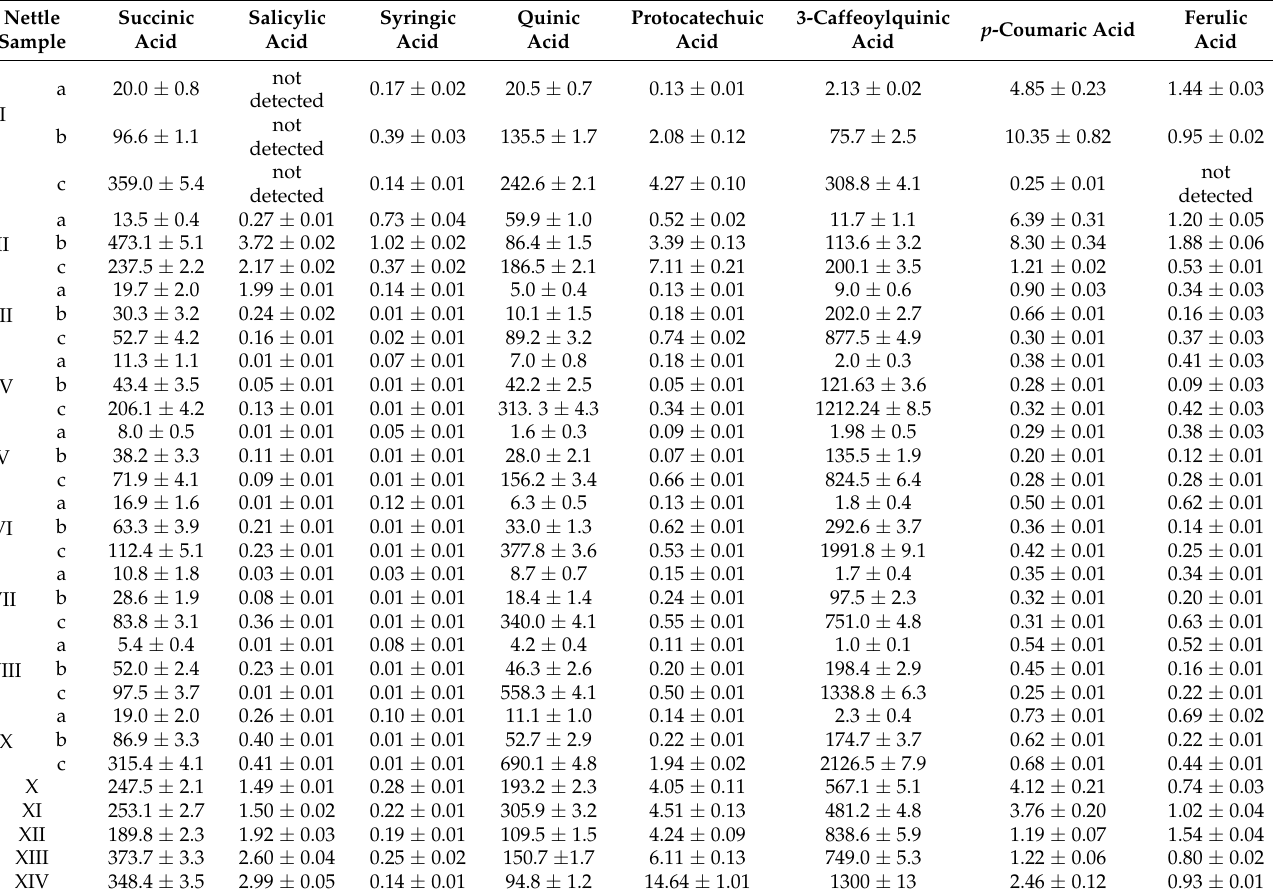
Table 4. Organic and phenolic acids in nettle determined with the use of LC–MS/MS ( µ g g − 1 of fresh weight); samples I–IX: a—root; b—stem; c—leaves; X–XIV—aerial parts of